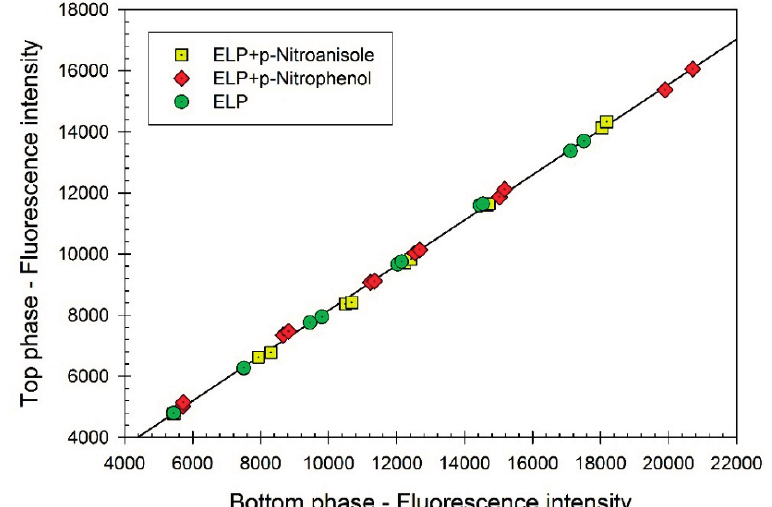
Figure 1. Concentration of elastin-like polypeptide (ELP) (represented by fluorescence intensity) in the top phase vs. concentration of ELP (represented by fluorescence intensity) in the bottom phase of aqueous Ficoll-PEG-0.01 M sodium phosphate buffer, pH 7.4 two-phase system. ELP, (GVGVP) 40 , was partitioned in the absence of additives (green circles), and in the presence of p -nitrophenol (red diamonds) or p -nitroanisole (yellow squares). Concentrations of ELP are measured in each phase with the o -phthaldialdehyde (OPA) assay. Slope of the linear curve represents the partition coefficient of